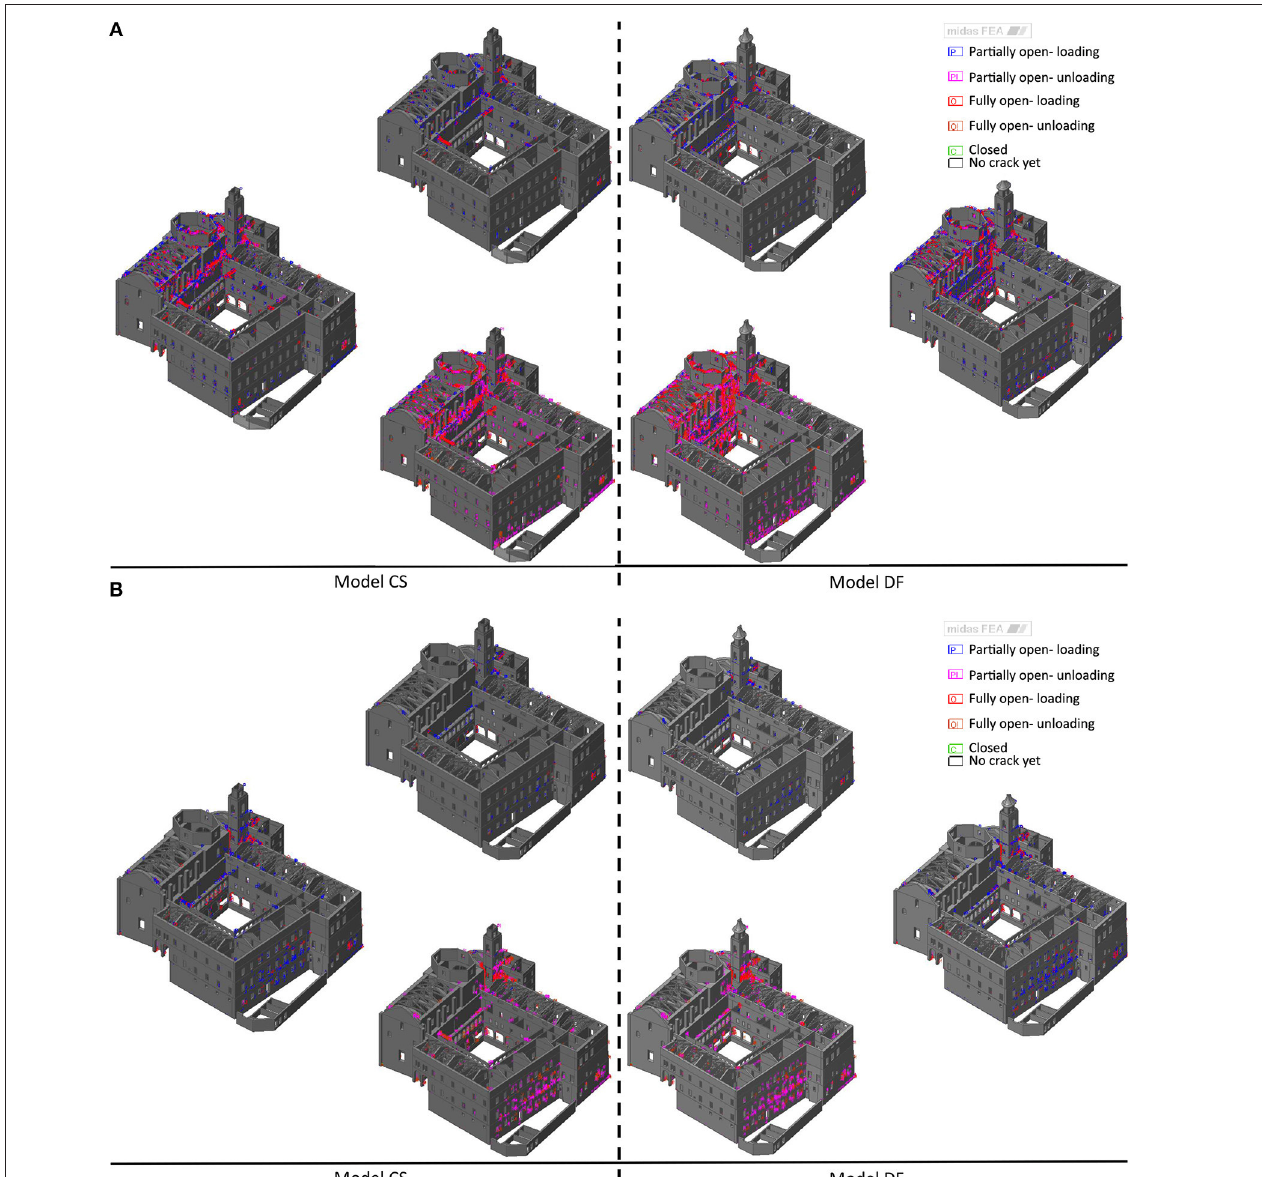
FIGURE 11 | Crack evolution for Model CS and Model DF for uniform loads in X-direction (A) Y-direction (B)